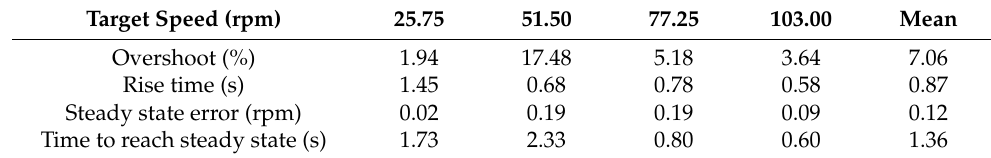
Table 4. Result statistics of the PID-based constant speed step response test.